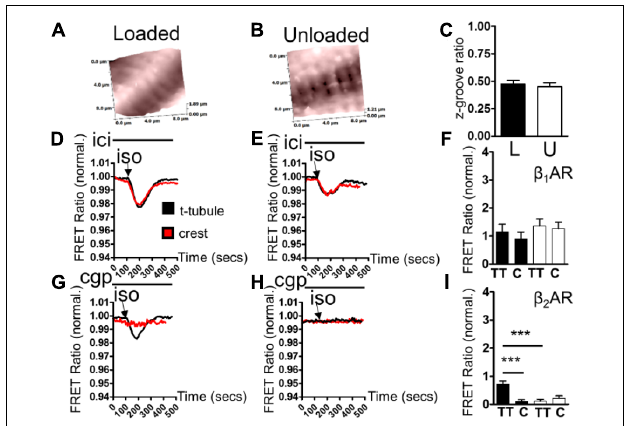
FIGURE 2 | (A) Illustrative topographical image of a loaded control cardiomyocyte membrane acquired with SICM. (B) Illustrative topographical image of an unloaded control cardiomyocyte membrane acquired with SICM. (C) Graph comparing the z-groove ratios of loaded and unloaded cells (loaded 0.473 ± 0.035 vs. unloaded 0.451 ± 0.035 N,n 5/(36-40) mean ± SEM NS). (D) Illustrative traces showing β 1 AR-cAMP (ICI+ISO) responses elicited in t-tubule or crest regions by combination SICM/FRET microscopy using the cEPAC2 sensor in a loaded cell. (E) Illustrative traces showing β 1 AR-cAMP (ICI+ISO) responses elicited in t-tubule or crest regions by combination SICM/FRET microscopy using the cEPAC2 sensor in an unloaded cell. (F) Graph comparing β 1 AR-cAMP responses evoked in t-tubule (TT) or crest (C) regions by SICM/FRET in loaded and unloaded cells (loaded t-tubule 1.155 ± 0.27% vs. loaded crest 0.903 ± 0.24%, unloaded t-tubule 1.356 ± 0.25% vs. unloaded crest 1.259 ± 0.232% N,n 5/6-9 mean ± SEM NS). (G) Illustrative traces showing β 2 AR-cAMP (CGP+ISO) responses elicited in t-tubule or crest regions by combination SICM/FRET microscopy using the cEPAC2 sensor in a loaded cell. (H) Illustrative traces showing β 2 AR-cAMP (CGP+ISO) responses elicited in t-tubule or crest regions by combination SICM/FRET microscopy using the cEPAC2 sensor in an unloaded cell. (I) Graph comparing β 2 AR-cAMP responses evoked in t-tubule (TT) or crest (C) regions by SICM/FRET in loaded and unloaded cells (loaded t-tubule 0.721 ± 0.106% vs. loaded crest 0.104 ± 0.062%, unloaded